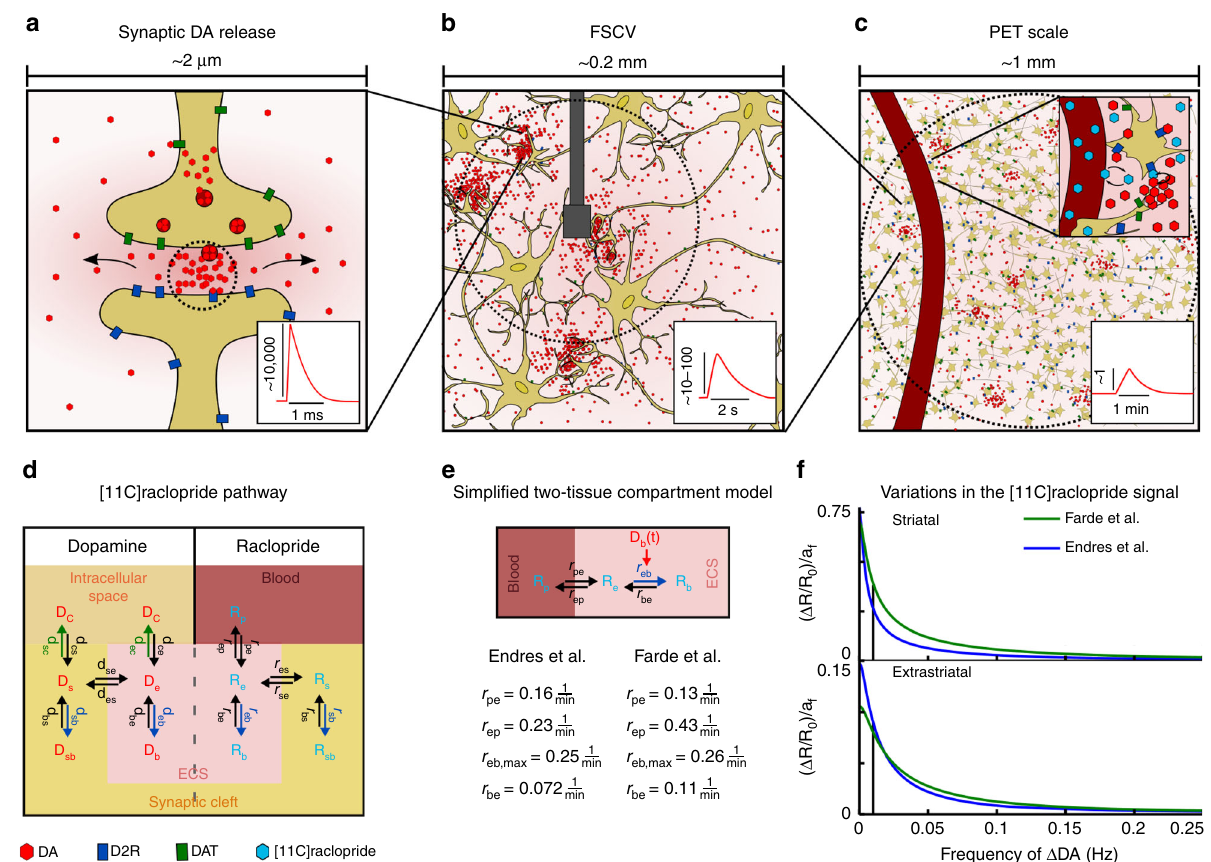
Fig. 1 DA release causes spatiotemporal variations of DA concentrations on multiple scales. a DA release increases synaptic DA concentrations by a factor of ~10,000 for ~1 ms. b Diffusion-driven out fl ow of DA from synapses increases DA concentration 10 – 100-fold in the close vicinity of synapses for ~2 s. These transients can be directly measured using FSCV. c DA is cleared from extracellular space by dopamine transporters (DAT). The time scale for clearance depends on the local DAT density. In a volume of 1 µ L part of the DA from synaptic release diffuses into regions with low DAT density and accordingly slow clearance rates of ~1 min. In the extracellular space DA competes with [11C]raclopride for binding to D2 receptors. Unbound [11C] raclopride concentration is in equilibrium with [11C]raclopride concentration in the blood (vessel shown in dark red). d Synaptic and extracellular tissue compartments are shared by DA and [11C]raclopride, DA is supplied from and cleared into axons (intracellular space), [11C]raclopride from the blood. DA compartments are labeled with D, transfer rate constants with d, [11C]raclopride compartments with R and transfer rate constants with r. Subscripts are c: intracellular space, p: plasma, s: synapse, e: extracellular (extrasynaptic) space, b: bound to D2 in ECS, sb: bound to D2 in synapse. e Effectively the [11C] raclopride PET signal is determined by the ECS. Temporal variations of D2-bound extrasynaptic DA modulate the [11C]raclopride binding constant r eb . Reported kinetic rate constants according to Endres et al. 21 and Farde et al. 22 . f Periodic changes of D b cause frequency-dependent periodic variations of the [11C]raclopride PET signal that are proportional to the amplitude a f of D b variations using kinetic rate constants from Farde et al. (green line) and from Endres et al. (blue line). a f can have values between 0 and 1, a f = 1 means that DA occupies 100% of the D2 receptors. Only variations at low frequency are detectable by PET. Extrastriatal variations were calculated assuming a D2R density of 5% of the striatal raclopride. Diffusion of DA between synapses and ECS causes variations of extracellular DA concentrations is directly propor- variations of DA concentration in the ECS even in the absence of tional to (and is therefore a potential measure of) synaptic DA direct DA release into the ECS. DATs transport DA from ECS activity (Fig. 1a – c, Fig. 2). and synapses back into the cells ( d ec and d sc in Fig. 1d). In the following model, we only take into account DA binding to D2Rs Variations of extracellular DA cause PET signal variations . omitting other receptor types due to the speci fi c competition with After intravenous injection, [11C]raclopride is transported to the [11C]raclopride binding. As illustrated in Fig. 1d, DA and [11C] brain, where blood and brain concentrations in the extracellular raclopride both occupy ECS and synapses and compete for fl uid equilibrate. Within the brain, [11C]raclopride diffuses binding to D2R within these compartments. through extracellular space which effectively consists of two compartments: the extracellular extrasynaptic compartment covering the fractional volume v e (referred to as ECS) and the synaptic compartment covering the fractional volume v s . Within each compartment [11C]raclopride binds to D2R according to its binding af fi nity which leads to the reaction pathway illustrated in Fig. 1d. Endogenous DA, released into synapses or directly into the ECS, partially occupies the same compartments as [11C]